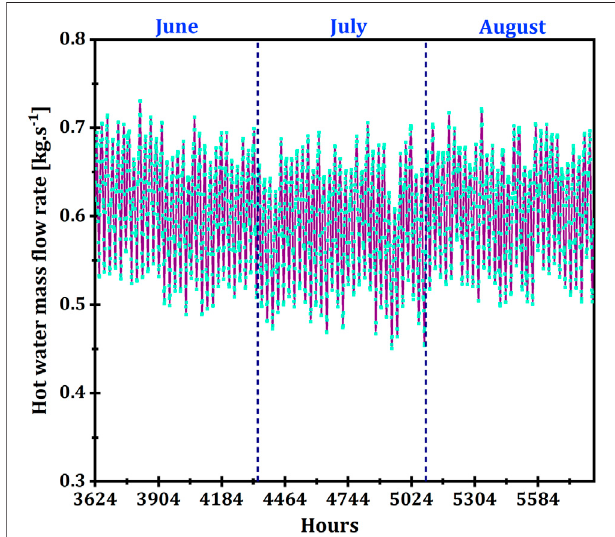
FIGURE 9 | Required hot water mass fl ow rate.